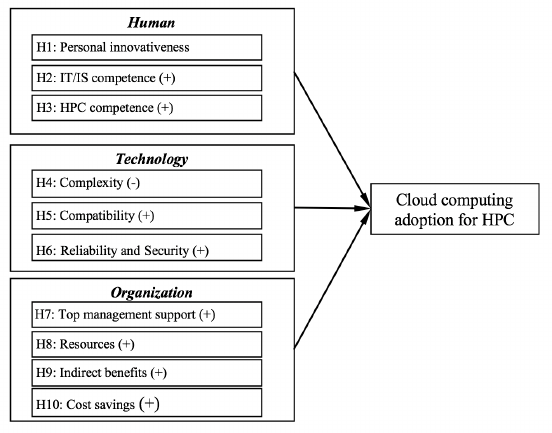
Figure 1. Proposed